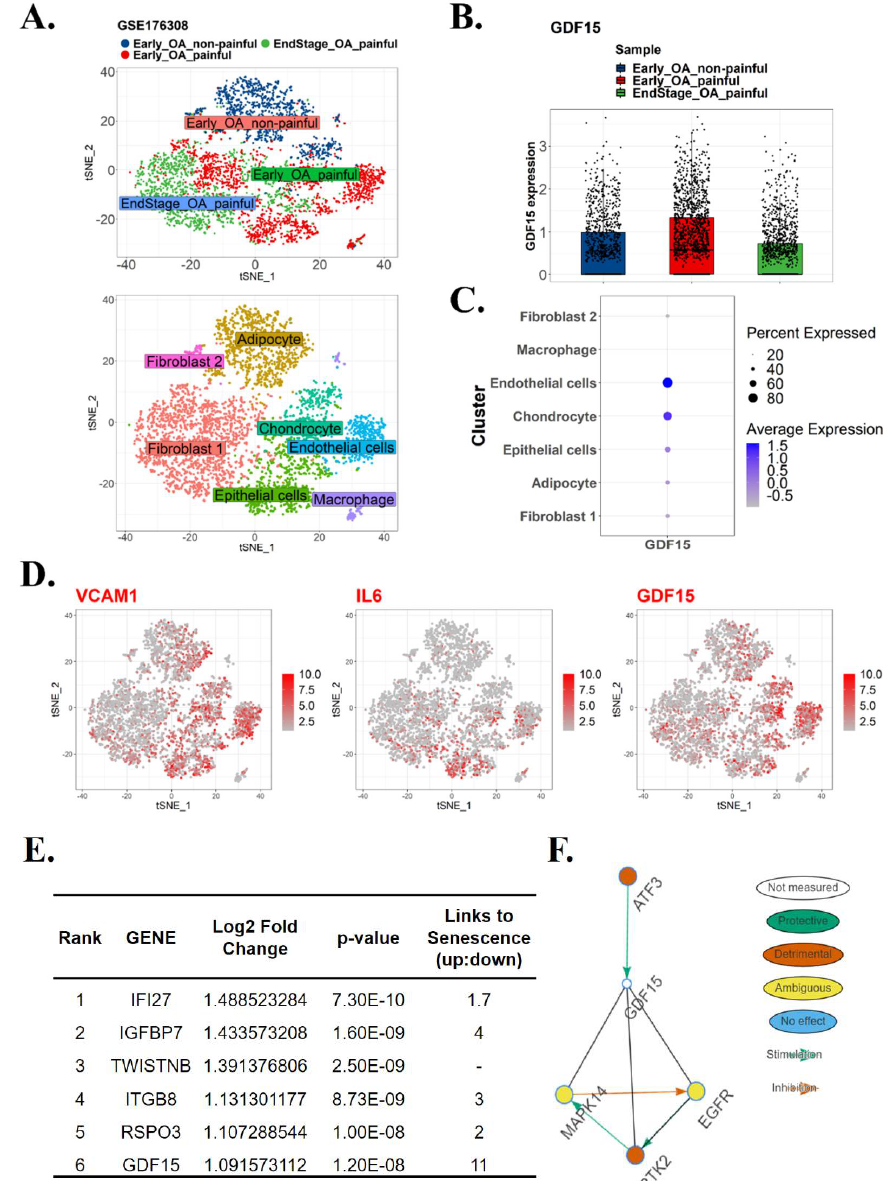
Figure 1. scRNA analysis depicting the overexpression of GDF15 in OA and its potential role in the MAPK14 pathway. ( A ) scRNA-seq analysis of the GEO data set GSE176308. Cells were clustered into Early_OA nonpainful, Early_OA painful, and Endstage_OA painful (left panel). Clusters of cells were identified (right panel). ( B ) GDF15 is highly expressed in the Early_OA painful cluster. ( C ) List of GDF15 expression based on cell cluster types. ( D ) Expression patterns of VCAM1, IL6,